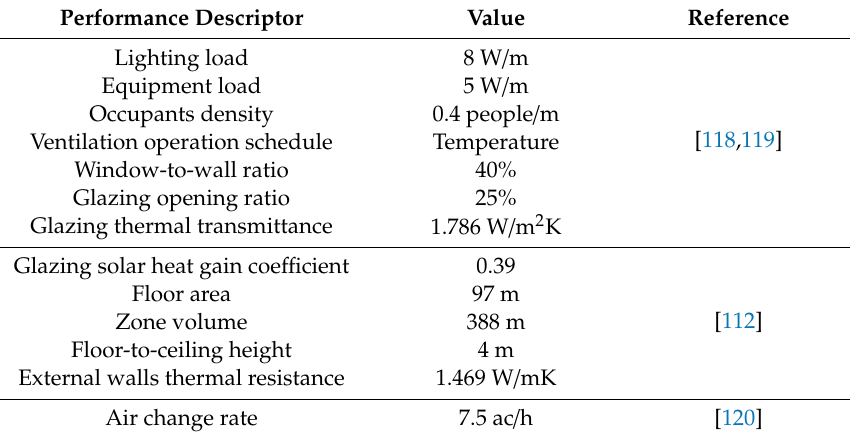
Figure 16. Base ‐ case building. Figure 16. Base-case building. Table 6. Performance descriptors of the base-case building. Table 6. Performance descriptors of the base ‐ case building.